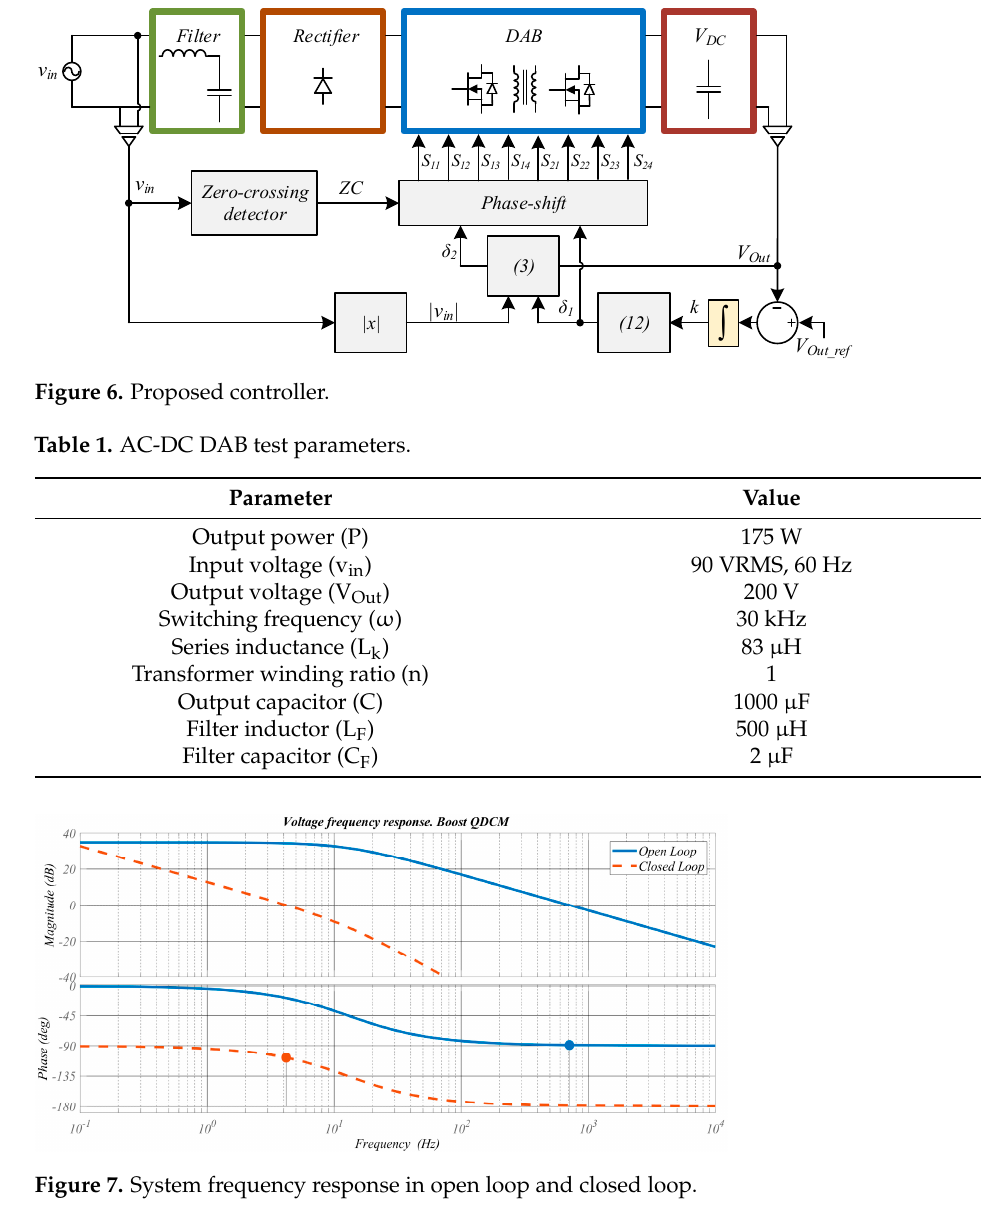
Figure 8. Prototype photograph. In Figure 9, the input voltage, the input current, and the series inductance current of the DAB converter are shown, when operating at nominal voltage and observing the low- frequency behavior. It is noted that the power factor is high, because the input current, as well as the input voltage, are in phase. Figure 9. Low-frequency signals of the AC–DC DAB converter. From top to bottom, input voltage (250 V/div), input current (5 A/div), and DAB series inductance current (25 A/div).